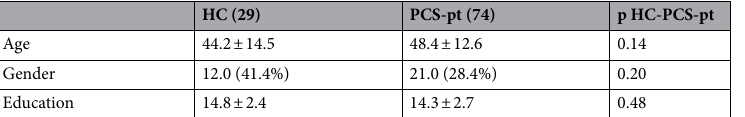
Table 3 resumes the results of clinical assessments of 72 PCS patients (two patients refused to undergo the evaluation): they presented high levels of perceived fatigue, mild levels of depression, and poor quality of sleep. The mean value and the value of the three parameters µ, σ and derived from ex-Gaussian fitting for Sustained Attention Task (SAT) in PCS patients and HC are reported in Table 4. All considered parameters were signifi- cantly higher in PCS patients than in HC. The Stroop task was correctly completed by 69 patients. The Stroop assessment in the remaining 5 patients was interrupted because of difficulties in understanding the task rules. The mean value of Stroop Task in Word Color Naming (WCN) and Color Naming (CN) conditions and Interference (I-ST) are reported in Table 5. Again, the values were significantly higher in PCS patients than in HC.